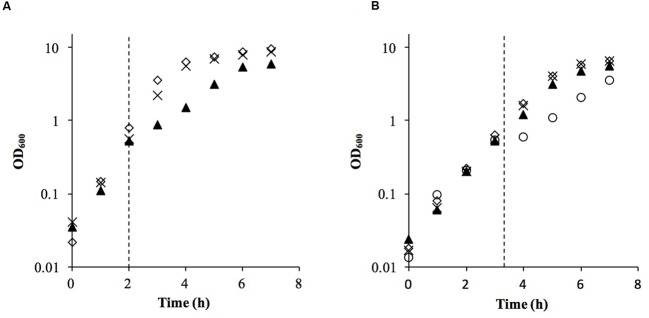
Growth of S. aureus Newman
(A) and S. epidermidis Tü3298 (B) challenged with sapienic acid. Bacteria were grown to OD600 = 0.5 before addition of sapienic acid (dotted line). Sapienic acid was added to concentrations 7.5 μM (cross), 11.25 μM (triangle) and 15 μM (circle)-Tü3298 only- or no addition, 0 μM (diamond).